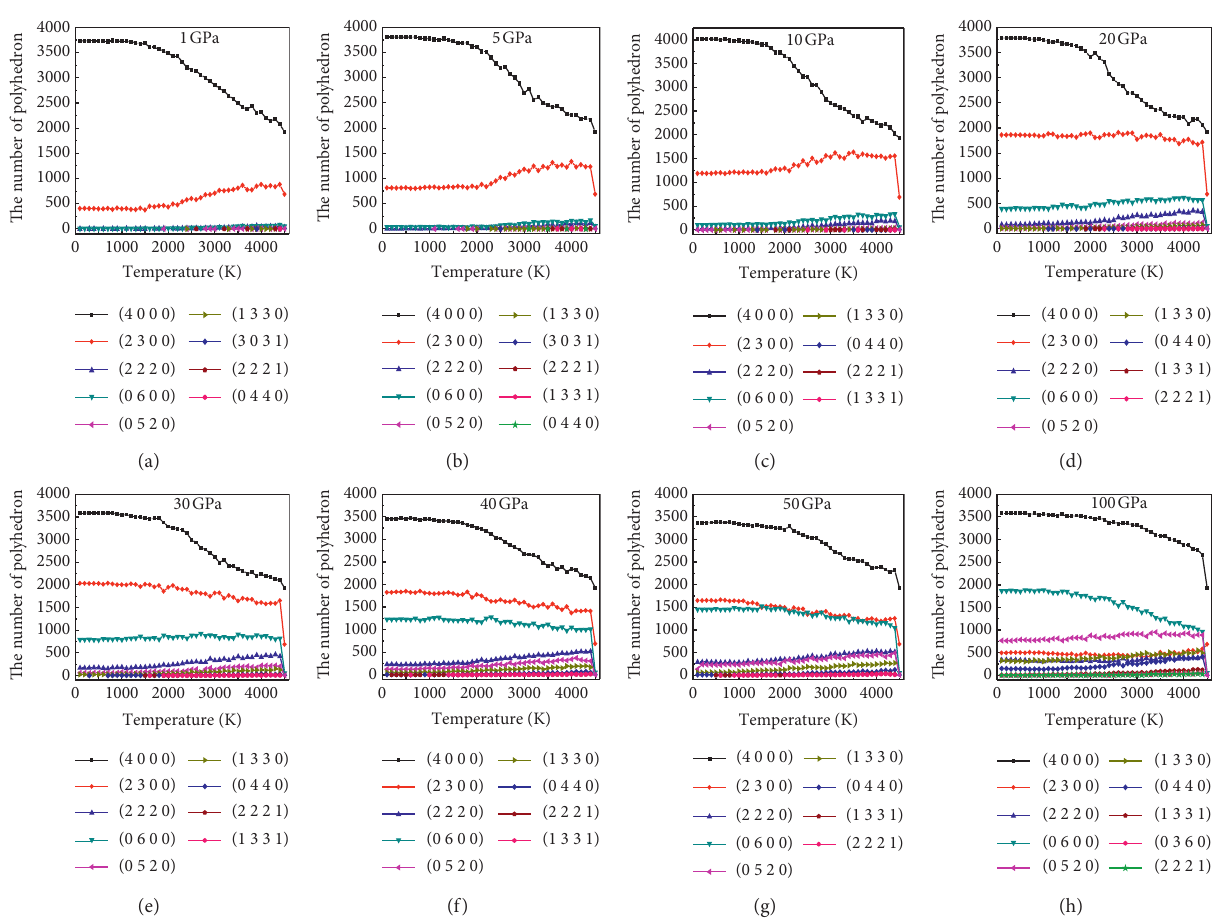
Figure 10: Variation in the number of Voronoi polyhedrons with temperature under different